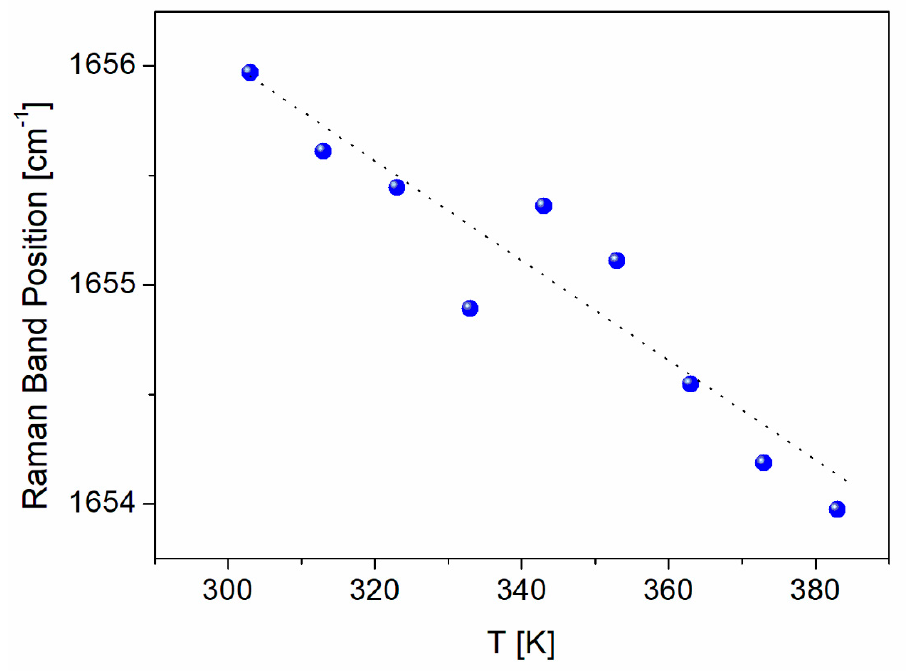
Figure 8. Temperature dependence of the Raman band position of BAT collagen related to amide I vibration. The line is a guide for the eye.